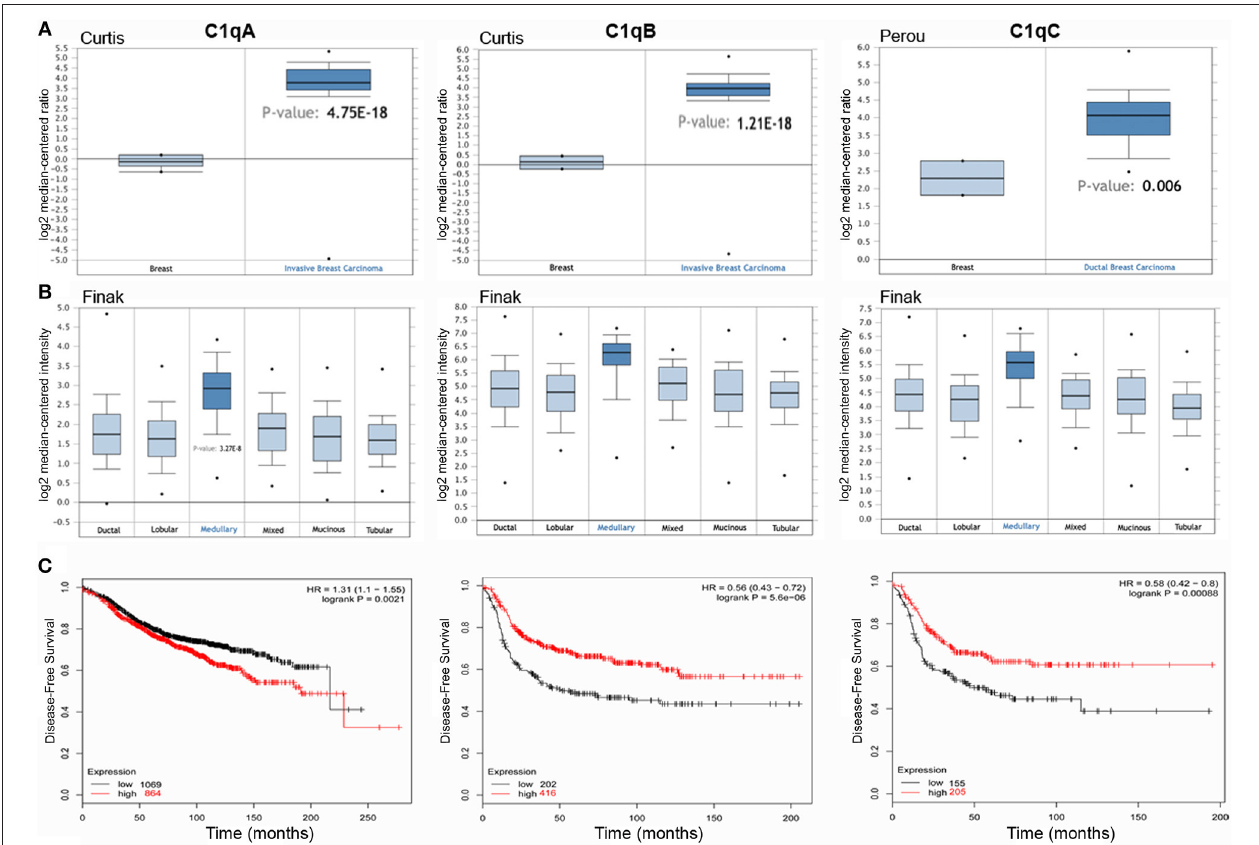
FIGURE 1 | C1QA , C1QB , and C1QC expression in invasive breast carcinoma. Curtis’s datasets were used for bioinformatics analysis to explore C1QA and C1QB mRNAs expression in the breast cancer, whereas Perou’s datasets was used for bioinformatics analysis to evaluate C1QC mRNA. A higher C1q mRNAs expression was detectable in invasive breast carcinoma compared to normal breast tissue (A) . The analysis of the different breast carcinoma histotypes by Finak’s dataset revealed how the medullary breast cancer presented the major intensity of C1q mRNA expression (B) . According to the data Kaplan-Meir plotter, C1QA, C1QB, and C1QC mRNA expressions was positively linked to a disease-free survival (DFS) rate in patients with basal-like cancers (C) ( p < 0.05) and to an overall survival (OS) rate with HER-2 positive cancers ( Supplementary Table 2 ). HR, hazard